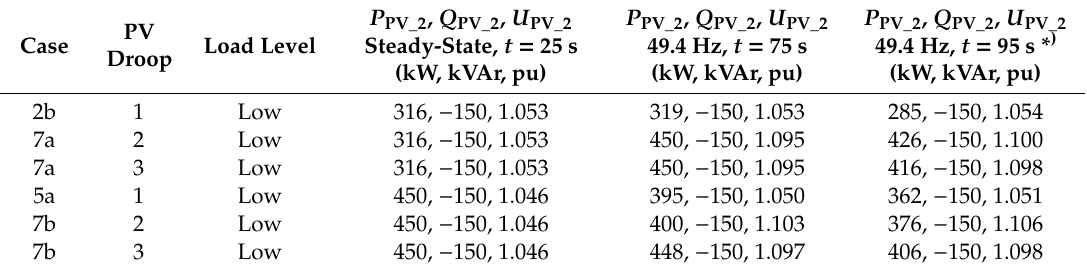
Table 7. PV 2 active ( P PV_2 ) and reactive ( Q PV_2 ) power as well as PV 2 connection point voltage ( U PV_2 ) during larger under-frequencies (49.4 Hz) (Figures 1 and 2, Tables